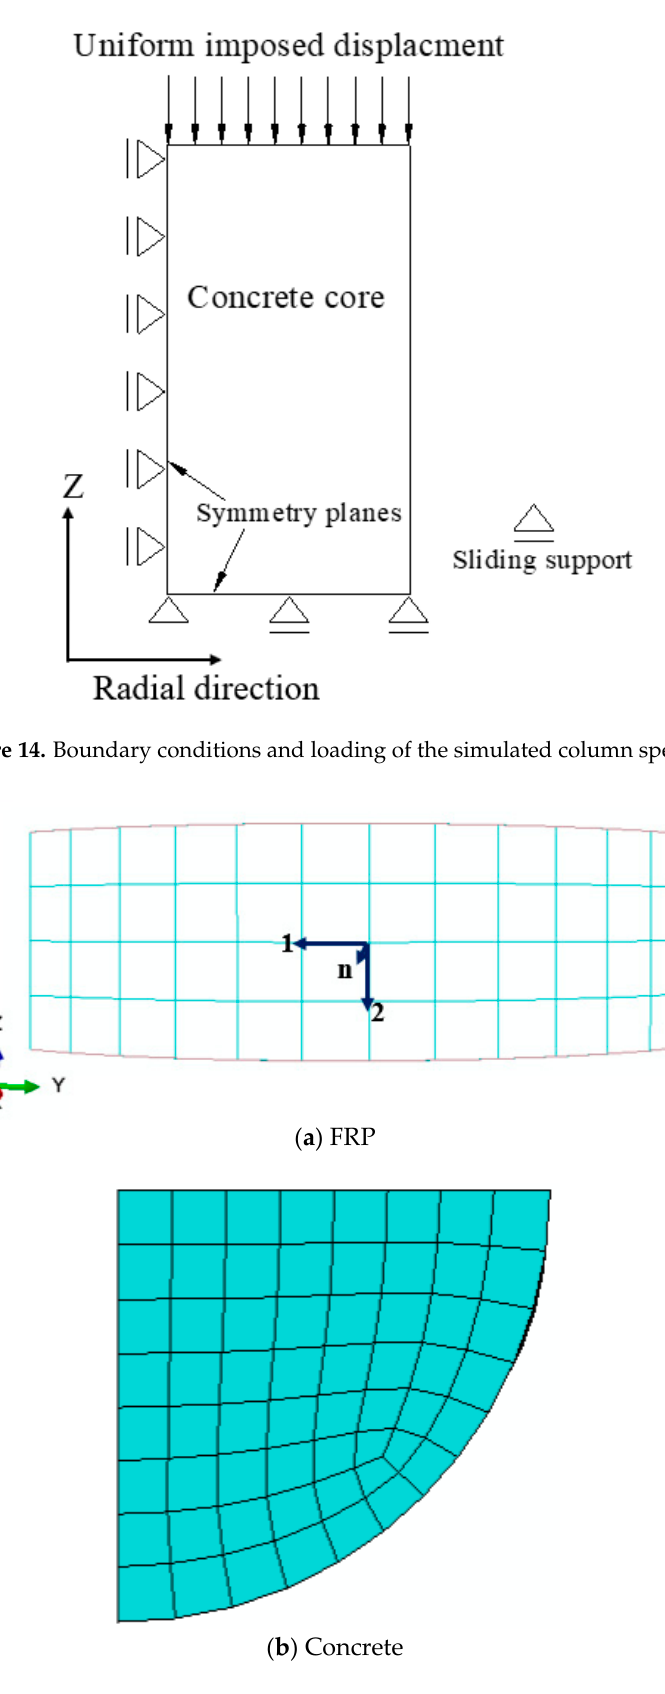
Figure 15. Meshing of the FE model.